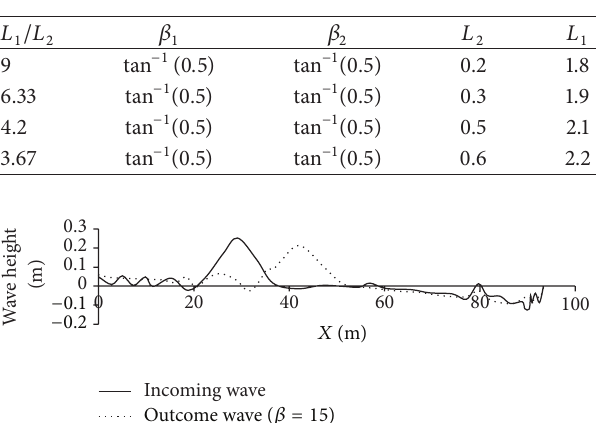
Table 5: Geometrical characteristics.